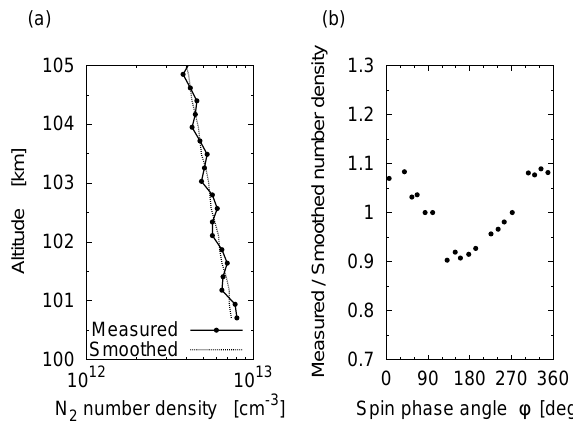
Fig. 3. Effect of spin modulation on the measured density pro- file between 100–105km altitudes in the ascent. (a) Measured and smoothed profiles. (b) Relative density changes plotted as a func- tion of the spin phase